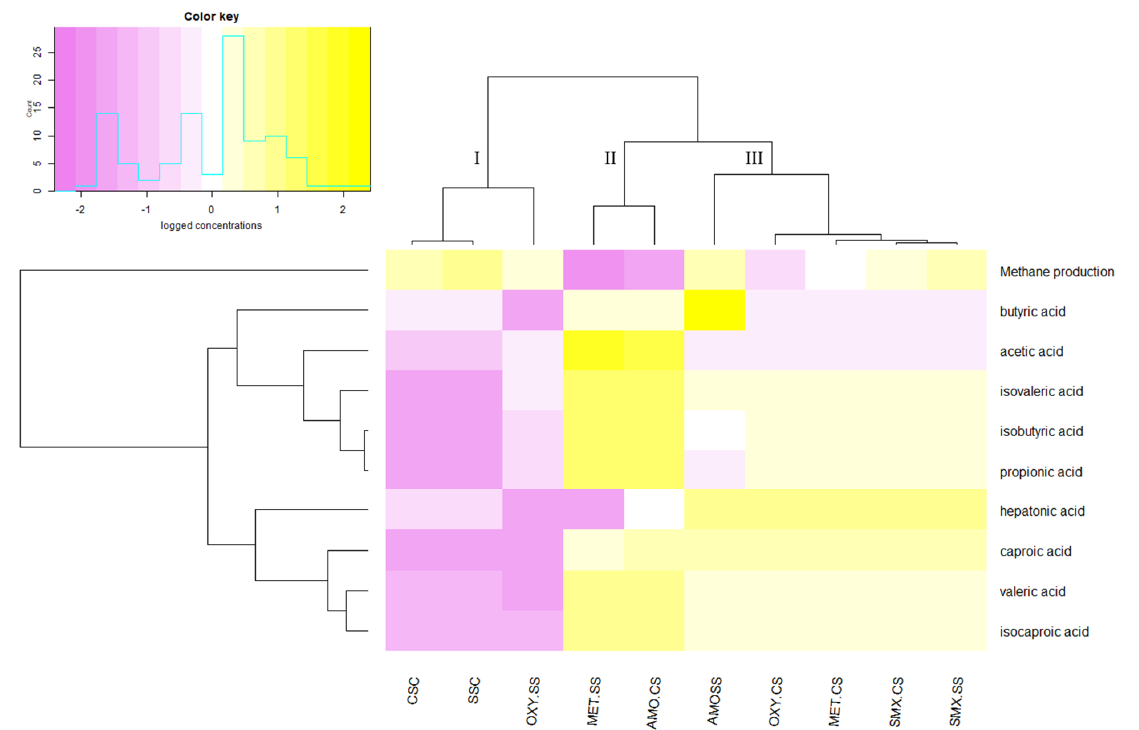
Figure 1. Heatmap with the logged values of methane production (L kg −1 VS) and VFAs concentrations (g L −1 ) in process and control bioreactors with sewage sludge (SS) and cattle slurry (CS). (SSC) control samples of sewage sludge, (CSC) control samples of cattle slurry.